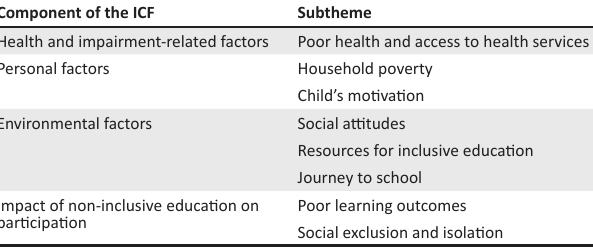
TABLE 2: Themes and